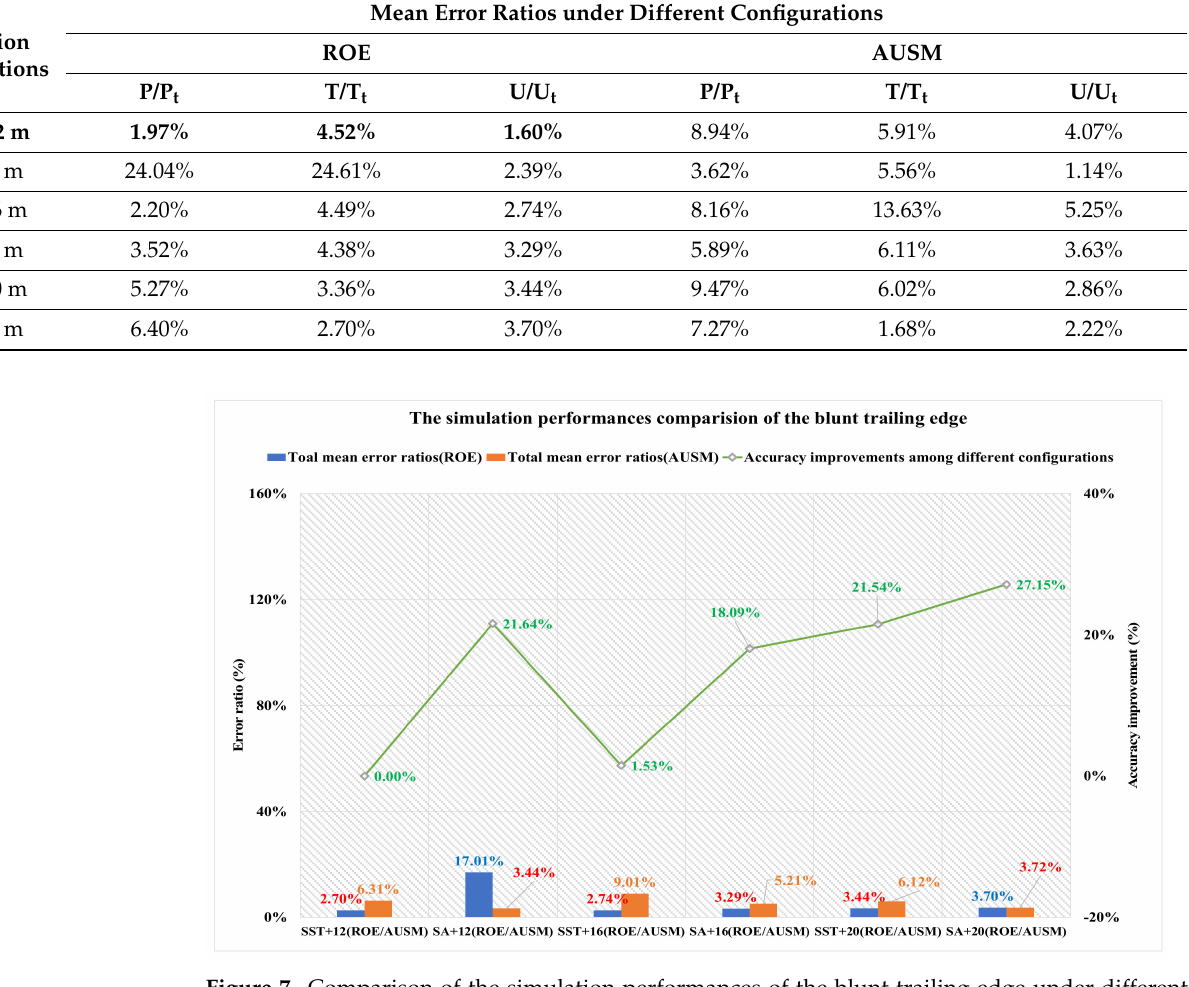
Figure 7. Comparison of the simulation performances of the blunt trailing edge under different sim-ulation